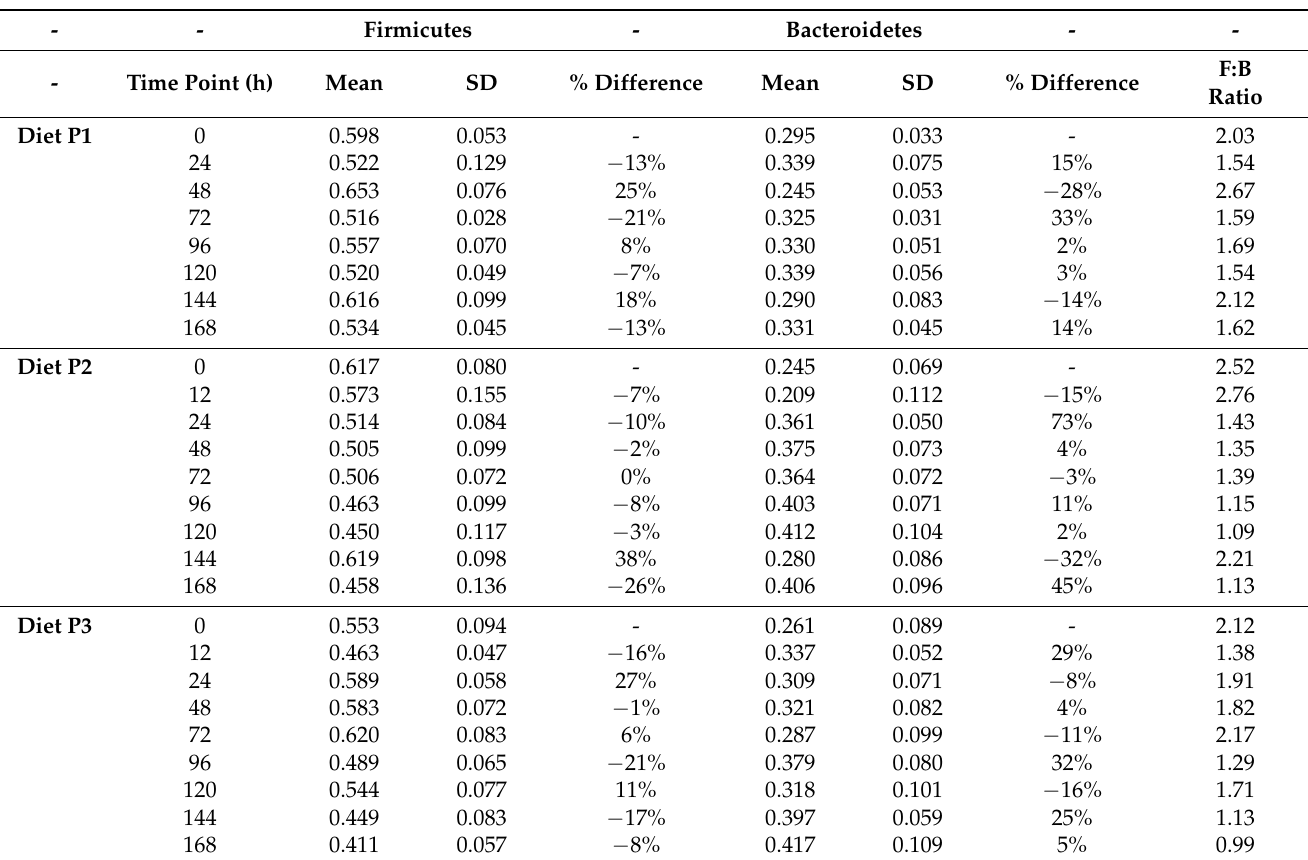
Table 5. Difference in the percentage of mean relative abundance of the two most dominant bacterial phyla from 0 to 168 h post dietary